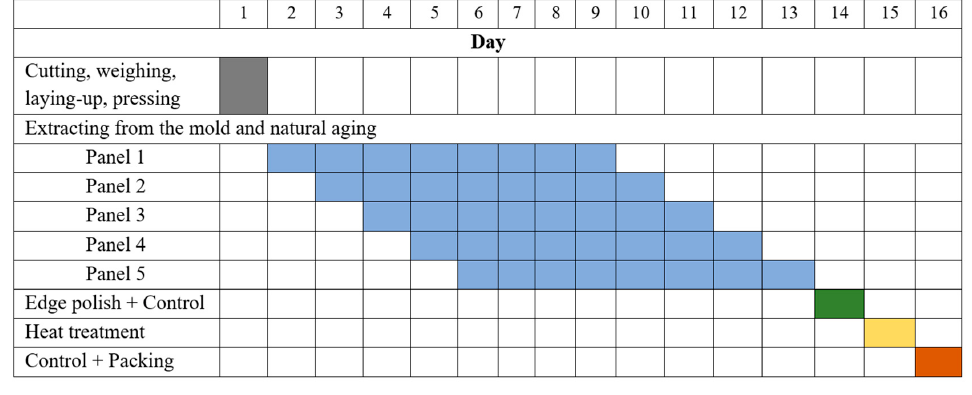
Figure 2. Gantt diagram for manufacturing a set of 5 panels made of 24 layers of glass fiber fabrics. Tests were performed at the Center for Research and Innovation for CBRN Defense and Ecology (Bucharest, Romania) and there the impact velocity was measured. Table 5 presents the characteristics of the levels FB2 and FB3. Each panel was hit in three points, with 120 mm between two points. The average measured values of the impact velocity were 375 m/s for FB2, meaning − 6.25% of the average value in standard, and 433 m/s for FB3, meaning + 8.25% of the average value in standard. The impact velocity was noted as v 0 and was measured using a projectile velocity measuring system, the Öehler 43 chronograph. The bullet hit from a distance of 5 m (normal conditions, [15]). Table 5. Characteristics of levels FB2 and FB3 as given in the classification and requirements for testing with hand guns and rifles